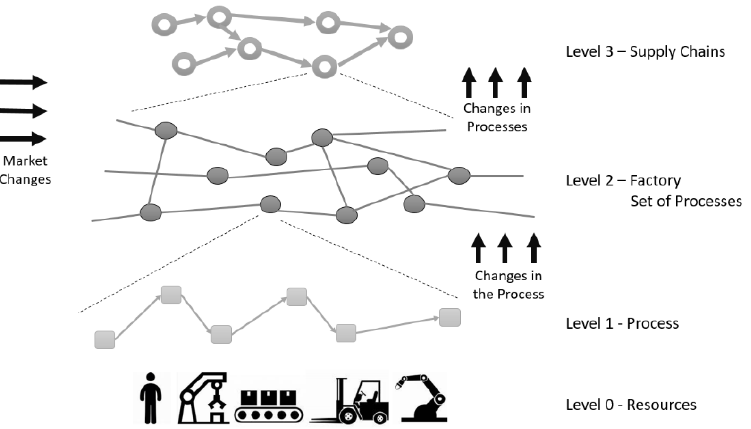
Figure 1. Levels of complexity in supply chains and factories and the impact of external and internal changes on the dynamics of the entire system.